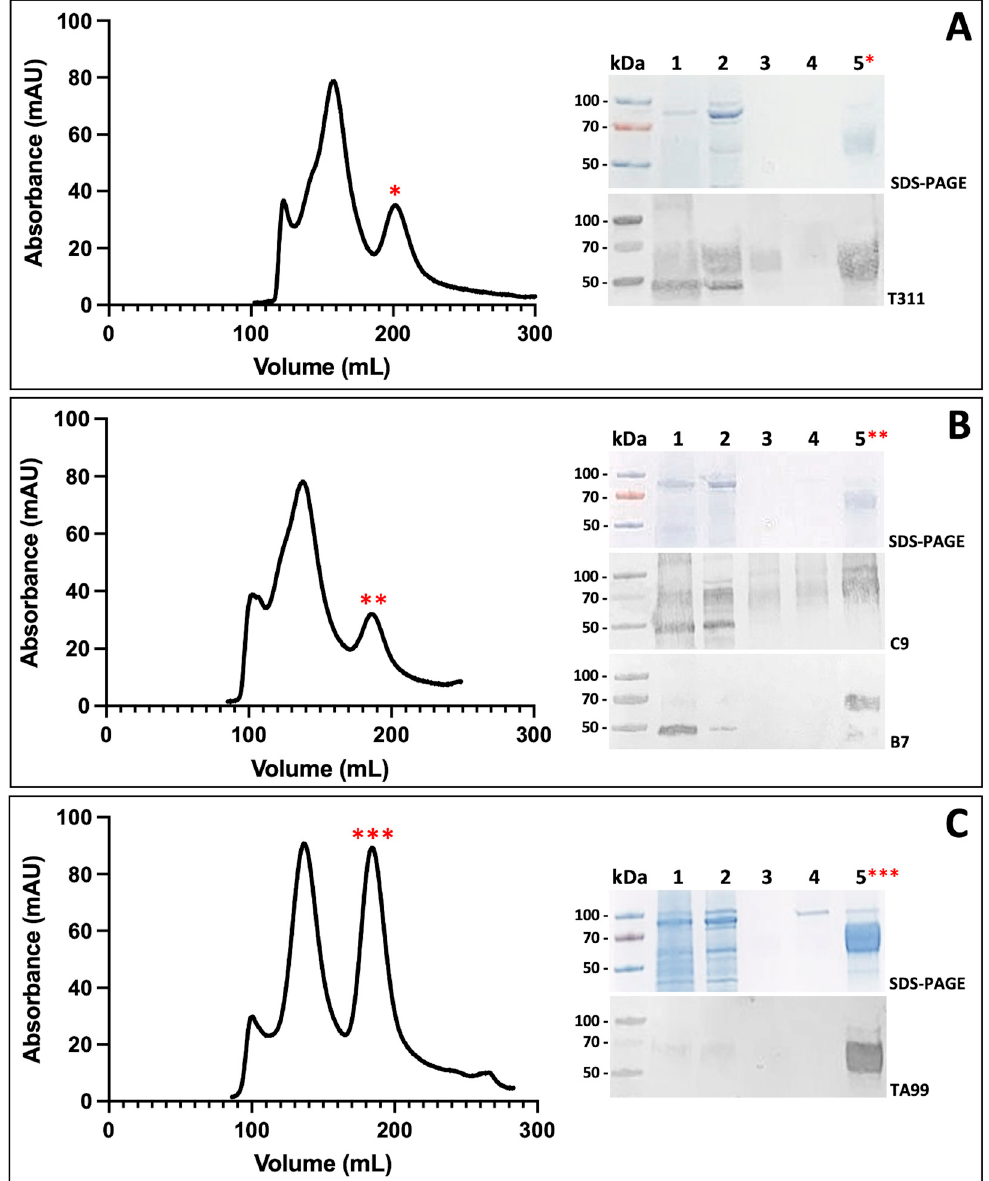
Figure 2. Purification profiles of lysates of recombinant human tyrosinases after 2nd step of purification using ÄKTAxpress. SEC profiles of TYR, TYRP2, and TYRP1 are shown in Panels ( A – C ), respectively. The inserts show the SDS-PAGE (top) and Western blot (bottom) analyses of the pellet before purification (1), lysate before purification (2), and the three peaks (3, 4, and 5). A protein of interest was identified in the third peak from the left (red asterisks) with an expected weight of ~60 kDa. T311, anti-TYR antibody; C9 and B7, anti-TYRP2 antibodies; TA99, anti-TYRP1 antibody.